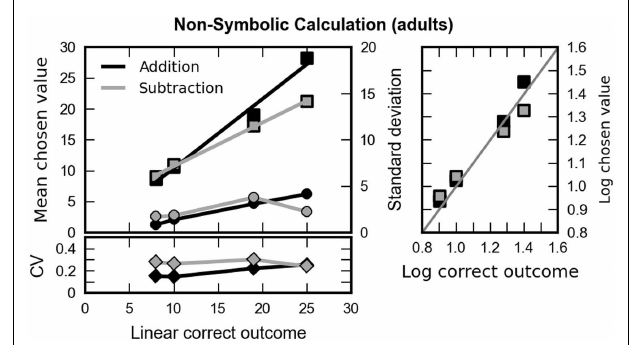
FIGURE 8 | Left column: mean responses (chosen values, squares) of the subjects and standard deviations (circles) plotted against the correct outcome for addition (black) and subtraction problems (gray) . The lower part depicts the coefficient of variation (CV, diamonds) – that is, the ratio of standard deviation and mean chosen value, plotted against the correct outcome. A constant coefficient of variation indicates that variability of chosen values increased proportionally with mean chosen value. In turn, this can be understood as an instantiation ofWeber’s law. Right column: the logarithm of the correct outcome plotted against the logarithm of the mean value chosen by the participants for addition (black) and subtraction (gray). The gray line indicates a ratio of 1 corresponding to perfect